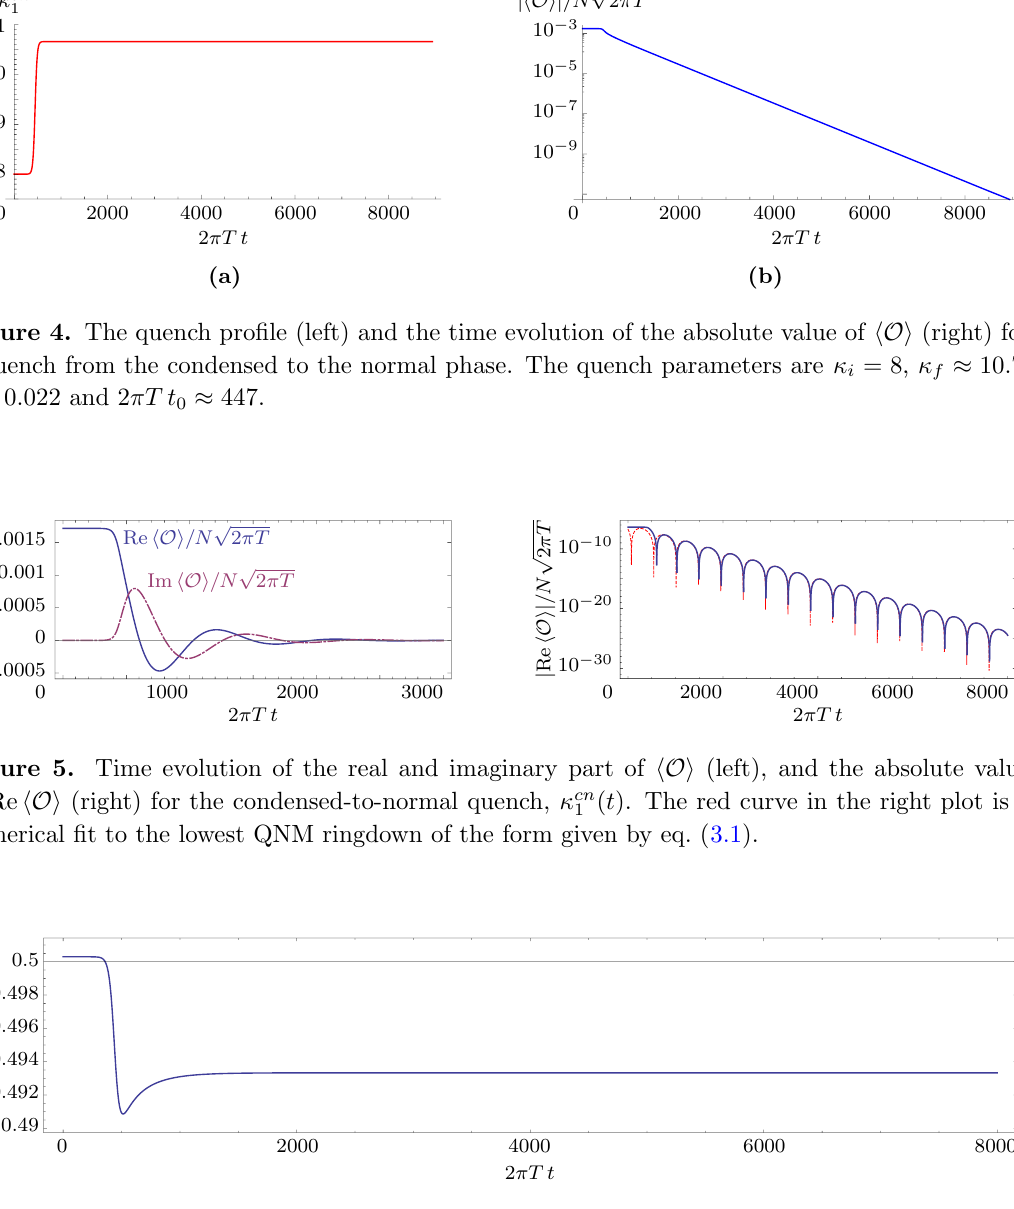
Figure 6. Time evolution of the gauge invariant quantity, (cid:1) t = (cid:22) (cid:0) @ t 0